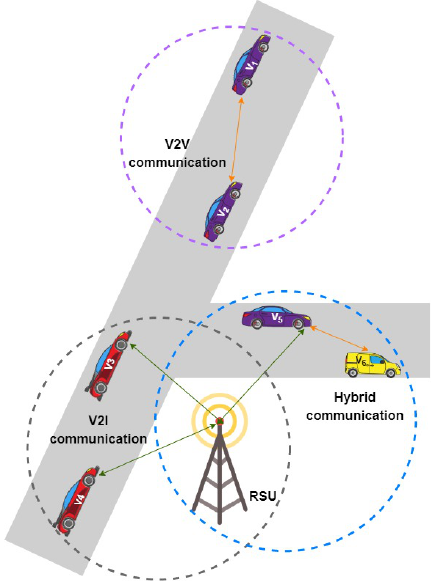
Figure 1. VANETs communication systems.